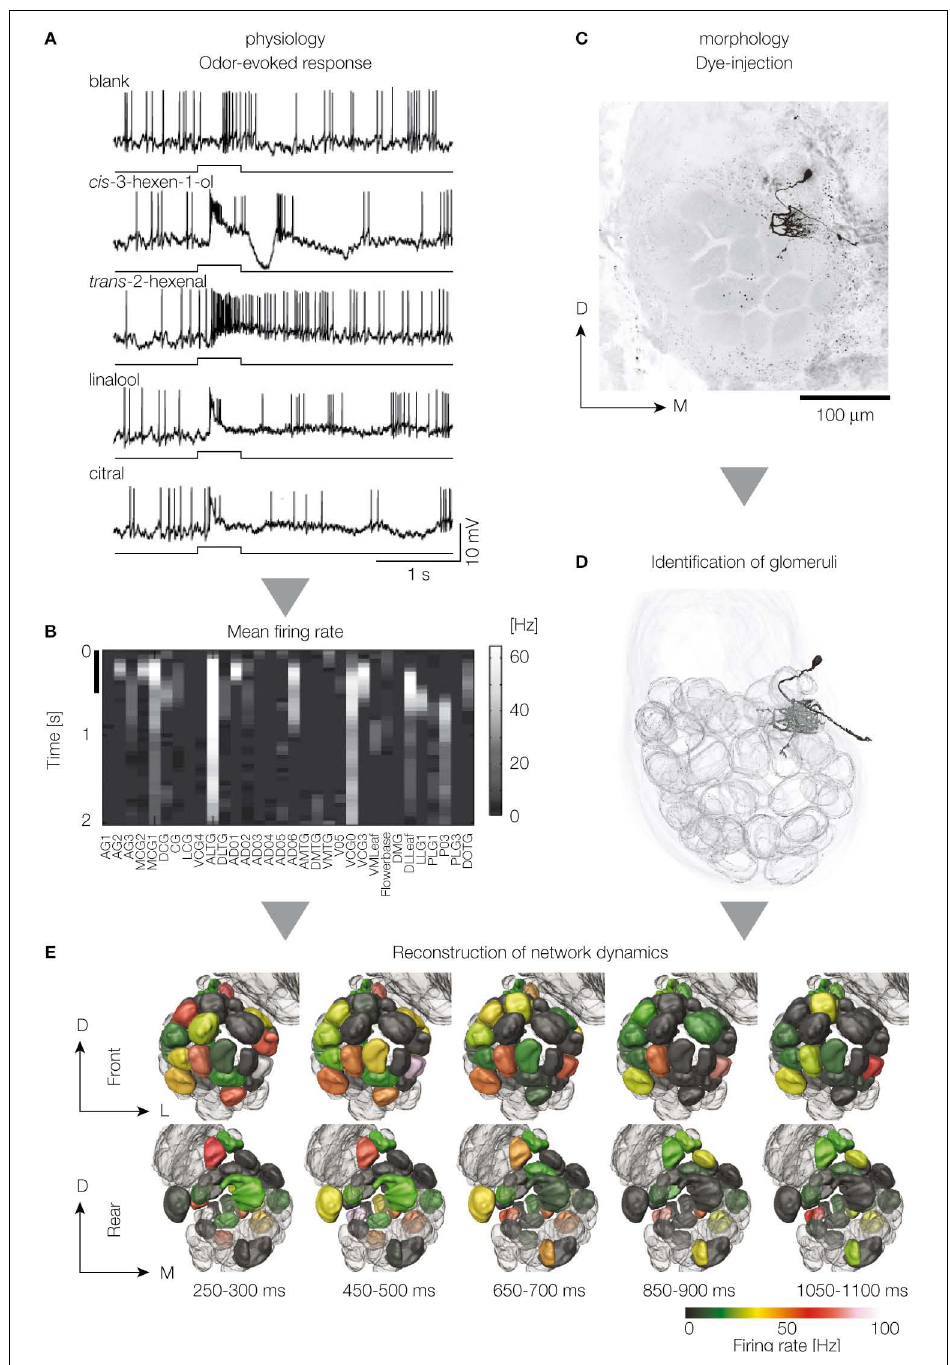
Figure 1 | Reconstruction of the population activity of the antennal lobe projection neurons. Data were obtained by in vivo intracellular recording and staining with glass microelectrodes. Odor-evoked fi ring activity is monitored (A) , averaged across trials, and mean fi ring rate for each time window is calculated (B) . Row and column mean time and glomeruli innervated by the stained projection neurons, respectively. Colors in the fi gure represent mean fi ring rate change for each projection neuron in response to cis -3-hexen-1-ol. Scale on the vertical axis represents the time period of odor presentation (500 ms). Dye-fi lled neurons are imaged by confocal laser scanning microscopy (C) , and the glomeruli innervated by the stained neurons are identifi ed (D) . Pooled data are integrated with geometrical information using a digital atlas (E) . Reconstructed odor-evoked activity by a virtual projection neuron population in response to cis -3-hexan-1-ol is shown. Upper and lower images show anterior and posterior views of the reconstructed dynamics. The number at the bottom is the time elapsed after the onset of odor presentation. Five time points are shown. D, dorsal; L, lateral; M,